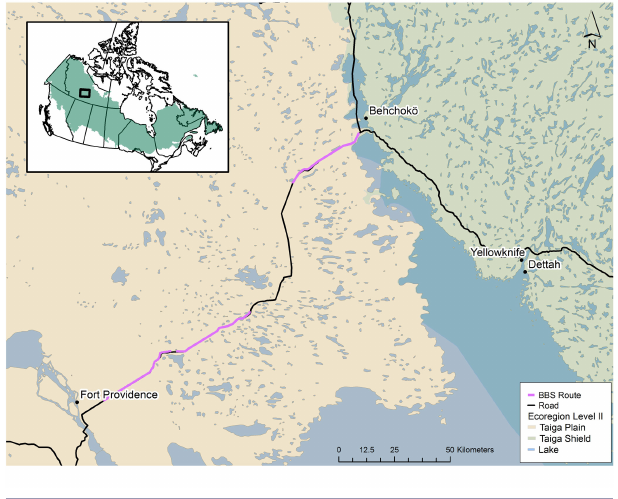
Fig. 1 . Location of the three North American Breeding Bird Survey (BBS) routes (pink) included in our study. BBS national coverage and the location of study area within Canada (black box) are shown in inset map. Study area was within the Taiga Plains ecoregion (Ecoregion Level II; Ecosystem Classification Group,